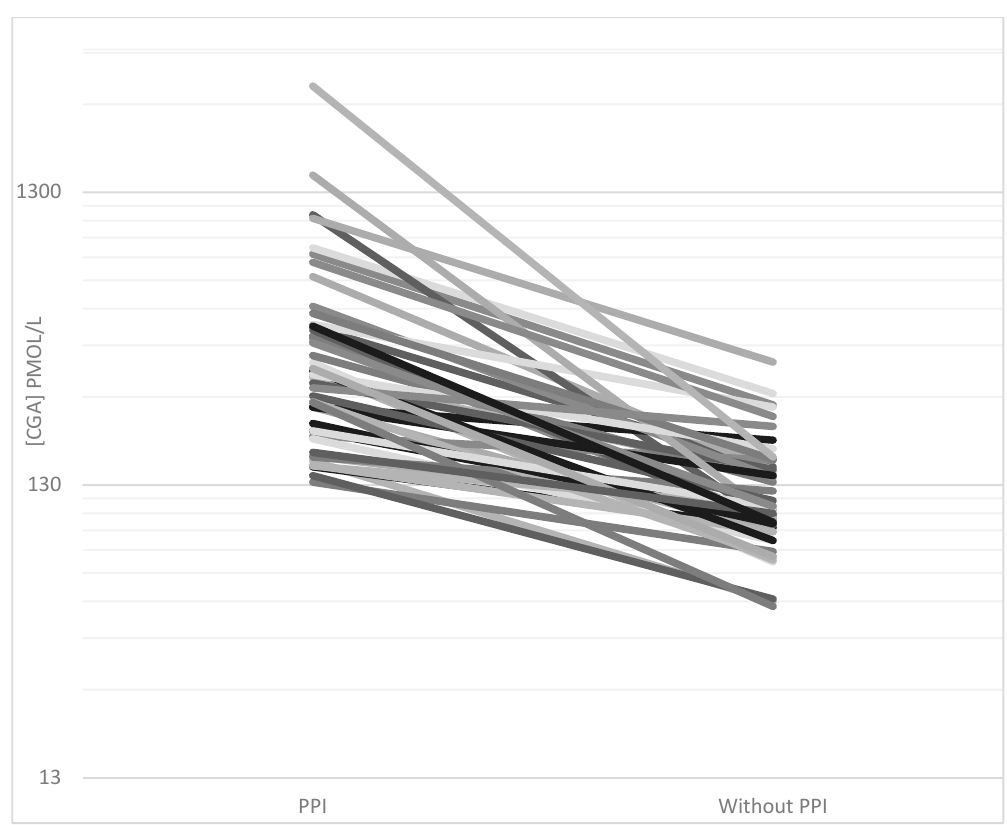
Figure 3. CgA plasma concentrations (pmol/L) in all patients with discontinued proton pump inhibitor (PPI) treatment. Plasma concentrations were measured using the CgA 340-348 radioimmunoassay during PPI treatment (pre-referral) and after discontinuation of PPI for at least one week (post-referral).